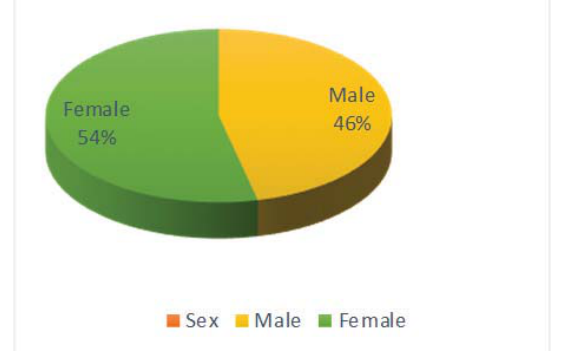
Figure 1. Sex distribution